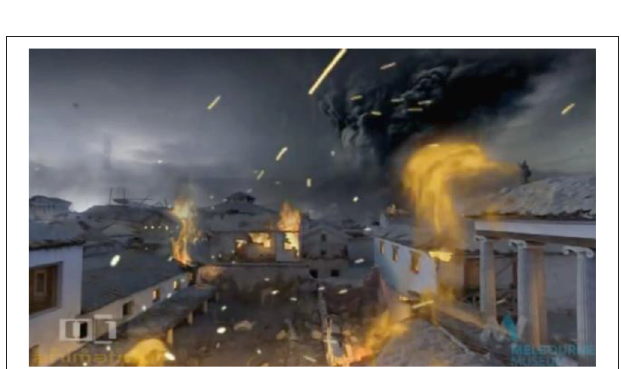
FIGURE 2 | “A day in Pompeii” I, 3 reproduced with the permission of the copyright holder (Zero One Studio).